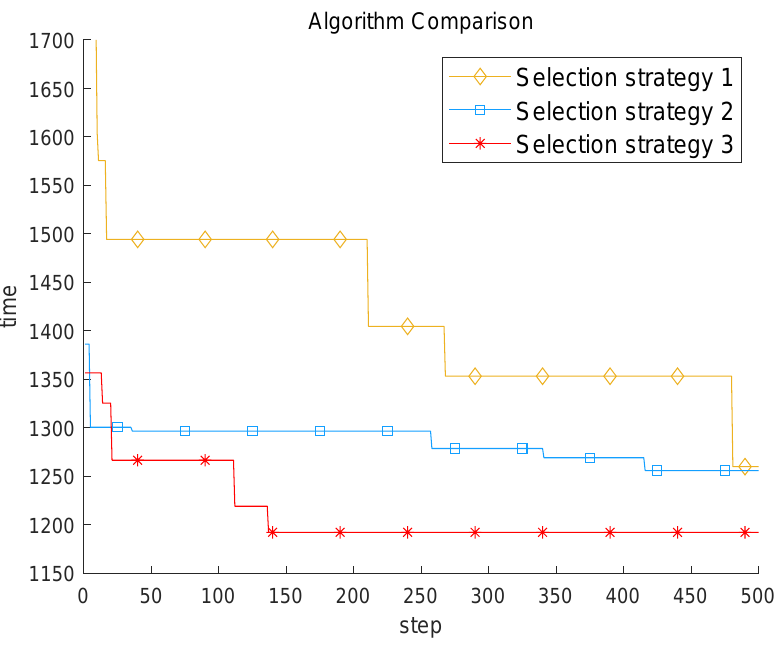
Figure 6. Selection strategy comparison based ERL.